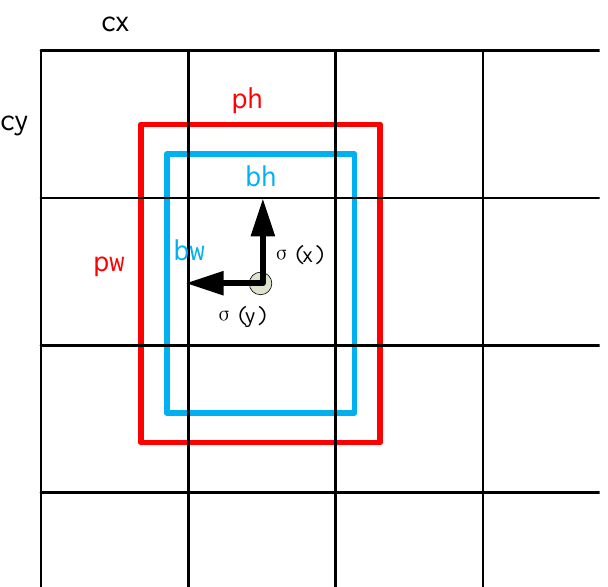
Figure 8. The red box is the a priori bounding box, and the blue box is a predicted